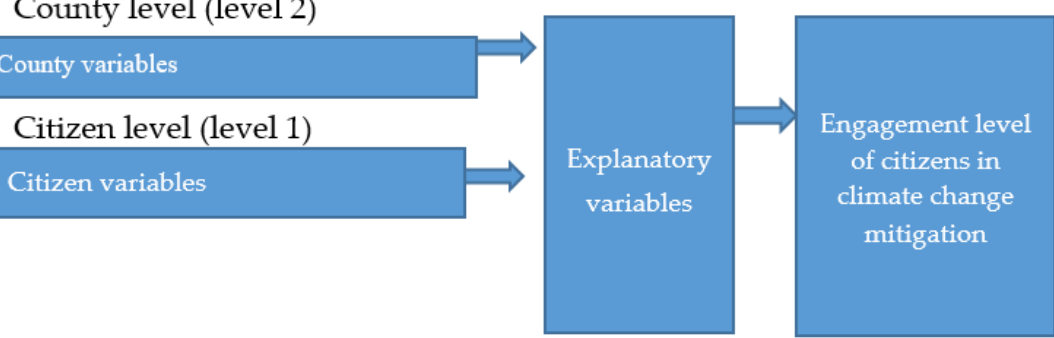
Figure 3. Conceptual framework of the main determinants for citizens’ engagement level in mitigating climate change. Source: Author’s contribution.